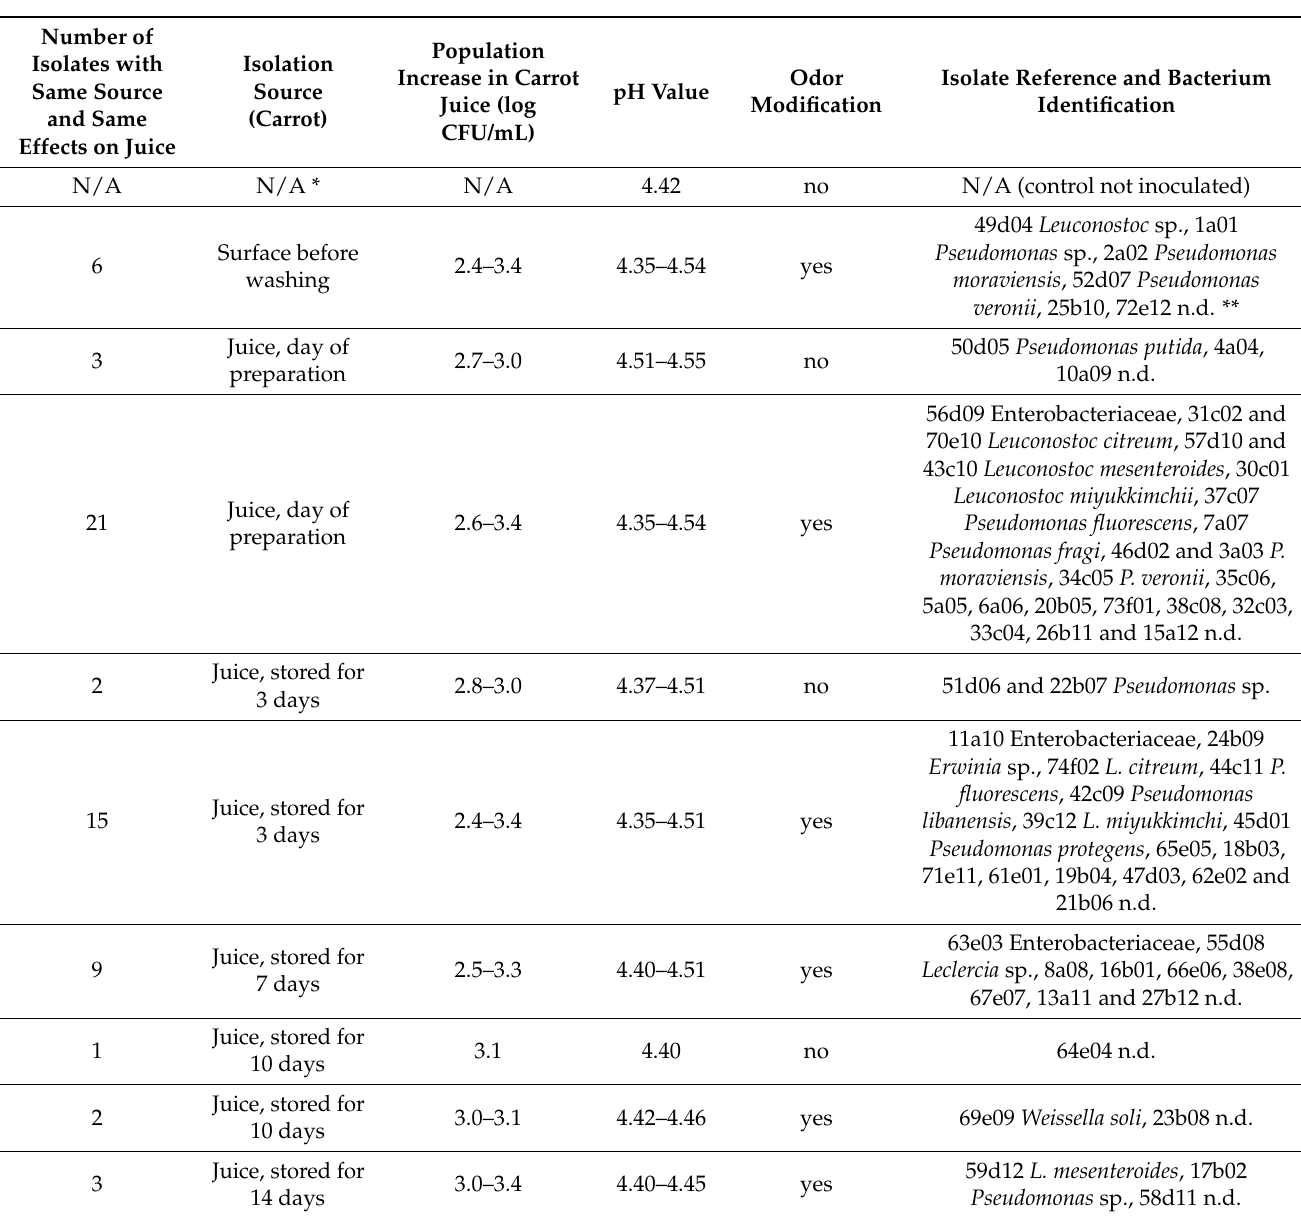
Table 3. Modification of commercial carrot juice following inoculation with selected microbial isolates. Different colors were used for isolate identification to indicate the microbial group: green for Leuconostoc , orange for Pseudomonas , blue for Enterobacteriaceae, purple for Weissella , and black for non-identified